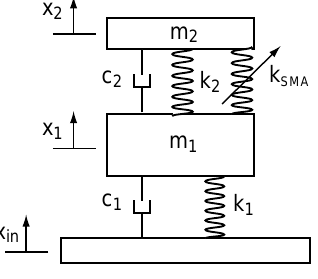
Fig. 6. A tuned vibration absorber model with variable stiffness SMA